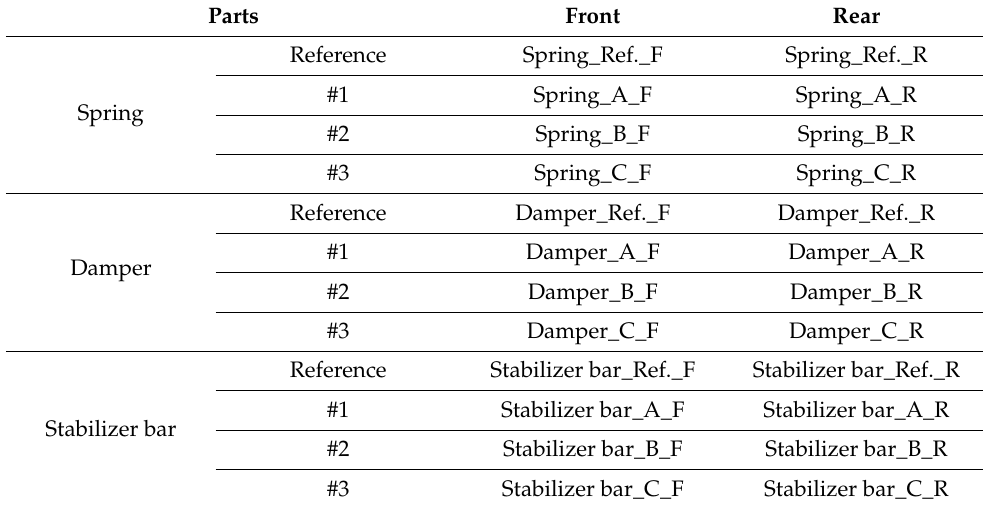
Table 2. Suspension component